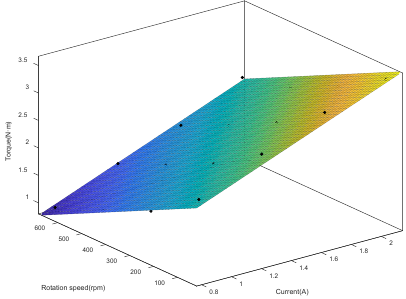
Figure 14. Motor characteristics diagram.